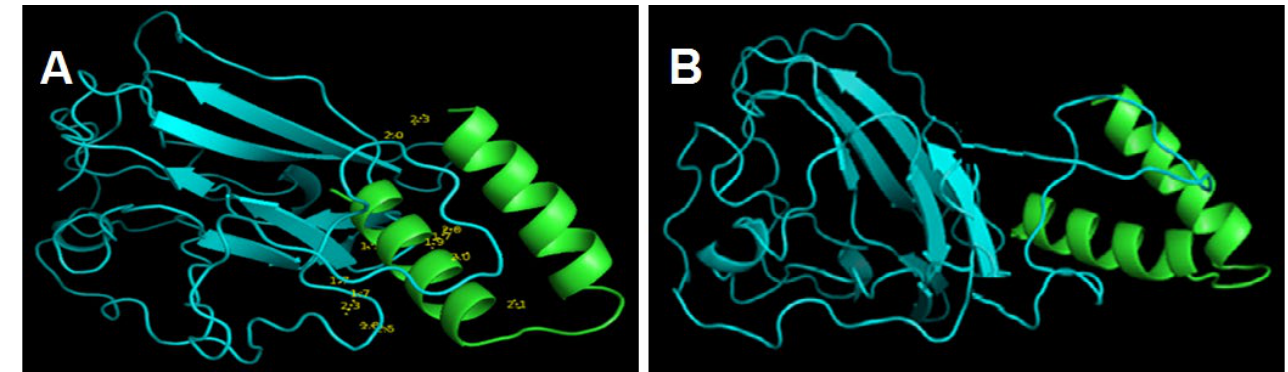
Figure 4. Docking results between the protein model (blue) and cLF36 (Green)(A) and the final structure of the system from Gromax (B). The link length ranged between 1.7Å and 2.5Å indicating a strong predicted association between the protein model and